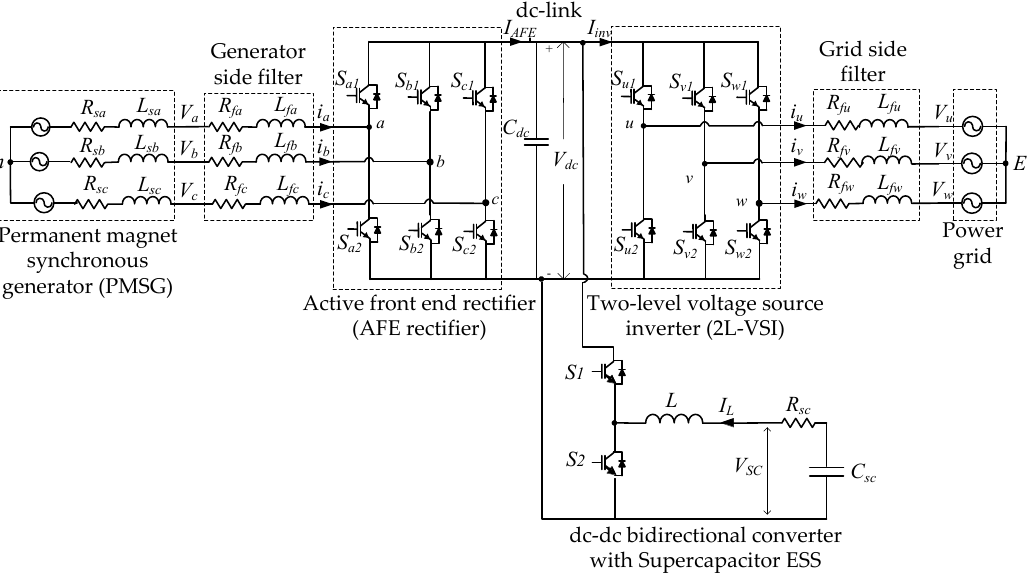
Figure 1. Schematic diagram of the grid connected oscillating water column (OWC) wave energy conversion (WEC) system with a supercapacitor energy storage system.